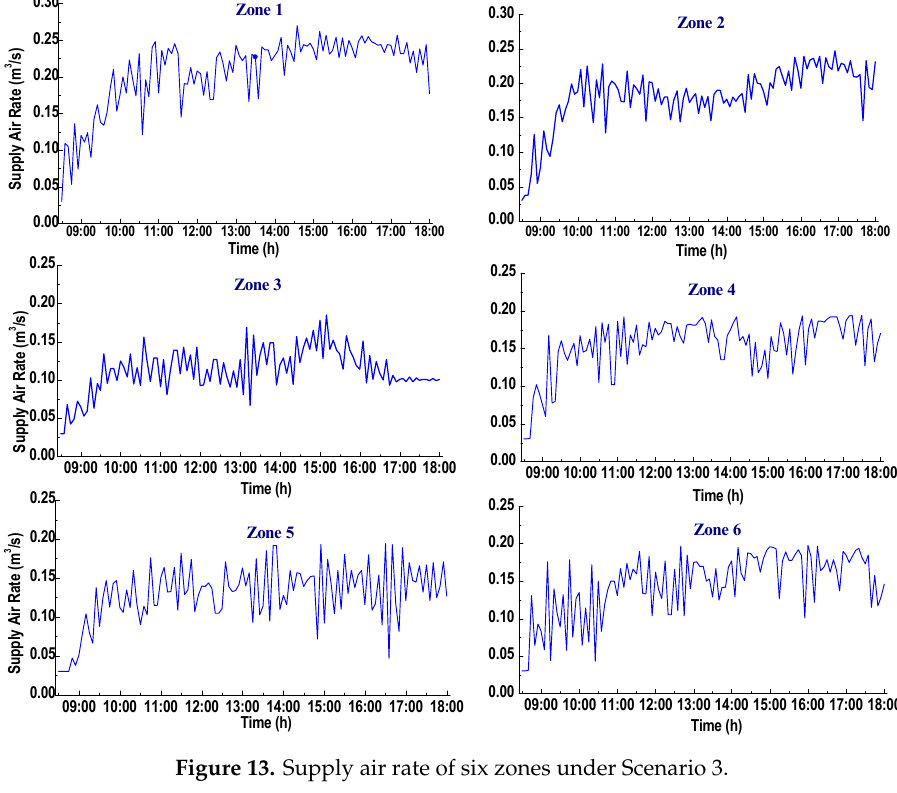
Figure 13. Supply air rate of six zones under Scenario 3.